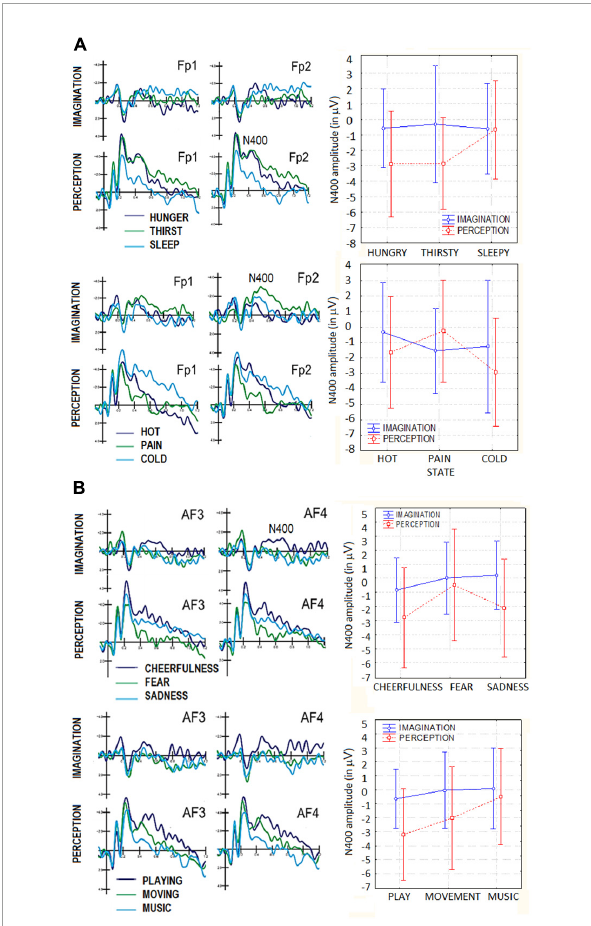
FIGURE4 (A) Grand-average ERP waveforms recorded at anterior scalp sites in the perceptual and imaginative conditions, as a function of motivational states. Top = primary needs; bottom = somatosensory sensations: (B) grand-average ERP waveforms recorded at anterior scalo sites in the perceptual and imaginative consition, as a function of motivational states. Top = affective states; bottom = secondary needs.